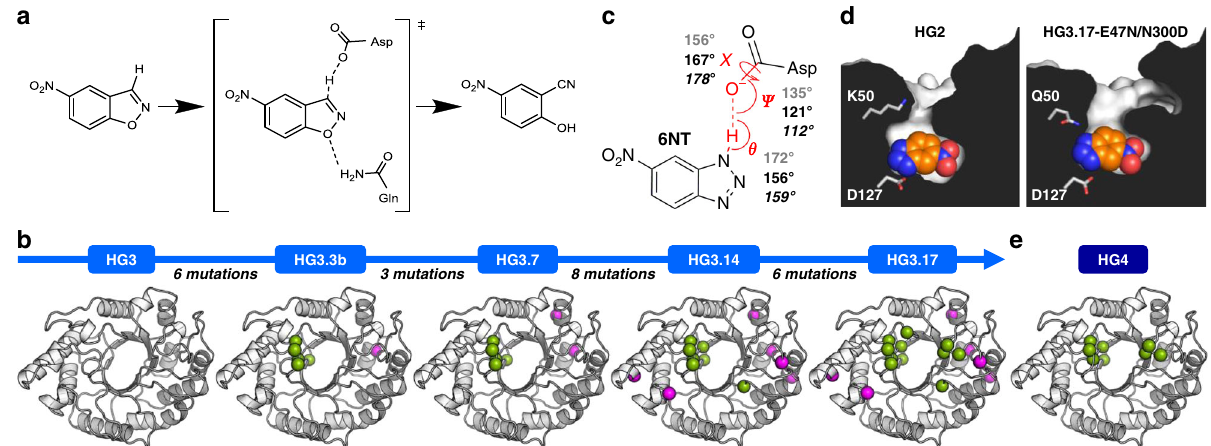
Fig. 1 HG series of Kemp eliminases. a HG enzymes catalyze the Kemp elimination reaction using a catalytic dyad consisting of a base (Asp127) that deprotonates 5-nitrobenzisoxazole, and an H-bond donor (Gln50) that stabilizes negative charge buildup on the phenolic oxygen at the transition state ( ‡ ). This reaction yields 4-nitro-2-cyanophenol. b Directed evolution of HG3, a higher-activity mutant (S265T) of the in silico design HG2. A total of 17 mutations (shown as spheres) were introduced during evolution, including 11 at positions within or close to the active site (green) and 6 at distal sites (magenta). c Angles describing the hydrogen bonding interaction between the transition-state analogue 6-nitrobenzotriazole (6NT) and Asp127 in the HG2 (PDB ID: 3NYD) 5 and HG3.17-E47N/N300D (PDB ID: 4BS0) 15 crystal structures are indicated in gray and black, respectively. Values in italics are optimal angles calculated for hydrogen bonding interactions between acetamide dimers 54 . d Cut-away view of the active-site pocket shows that its structural complementarity with 6NT (spheres) is improved in the higher-activity variant HG3.17-E47N/N300D. Key active-site residues are shown as sticks. e The HG4 variant engineered in this study contains 8 fi rst- and second-shell mutations found during